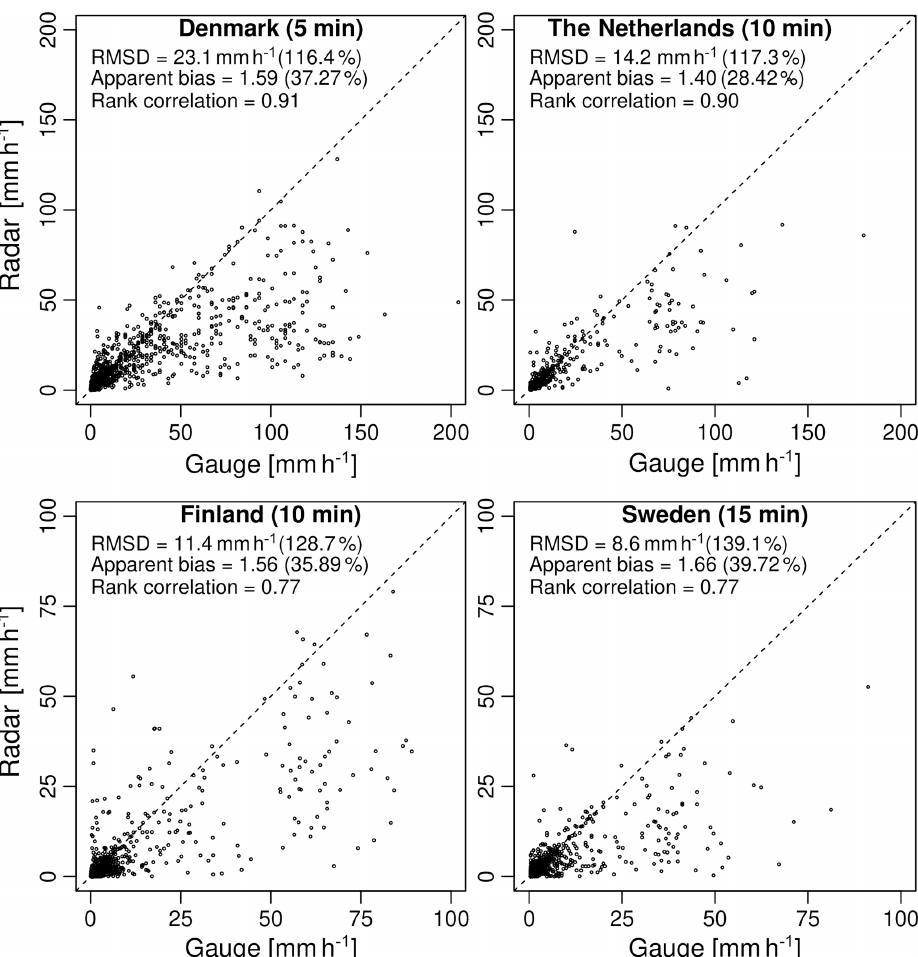
Figure 5. Radar versus gauge intensities (in mmh − 1 ) at the highest available temporal resolution for each country (all 50 events combined). The dashed line represents the